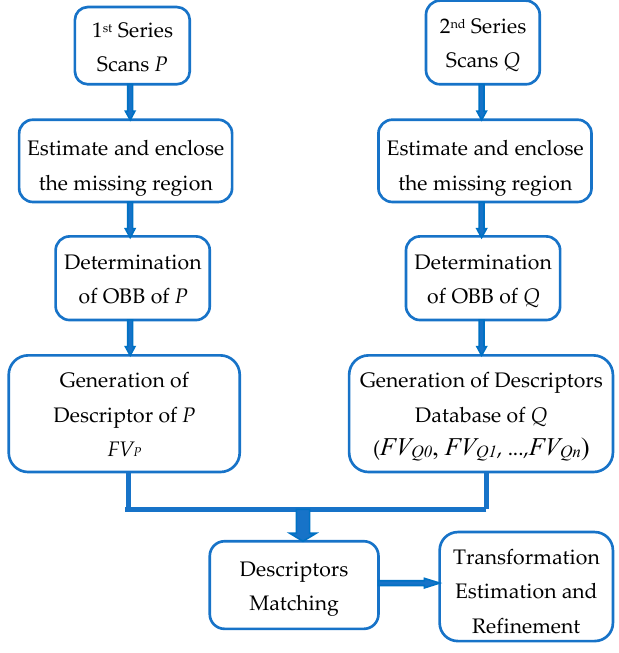
Figure 3. The flow chart diagram of the proposed method.